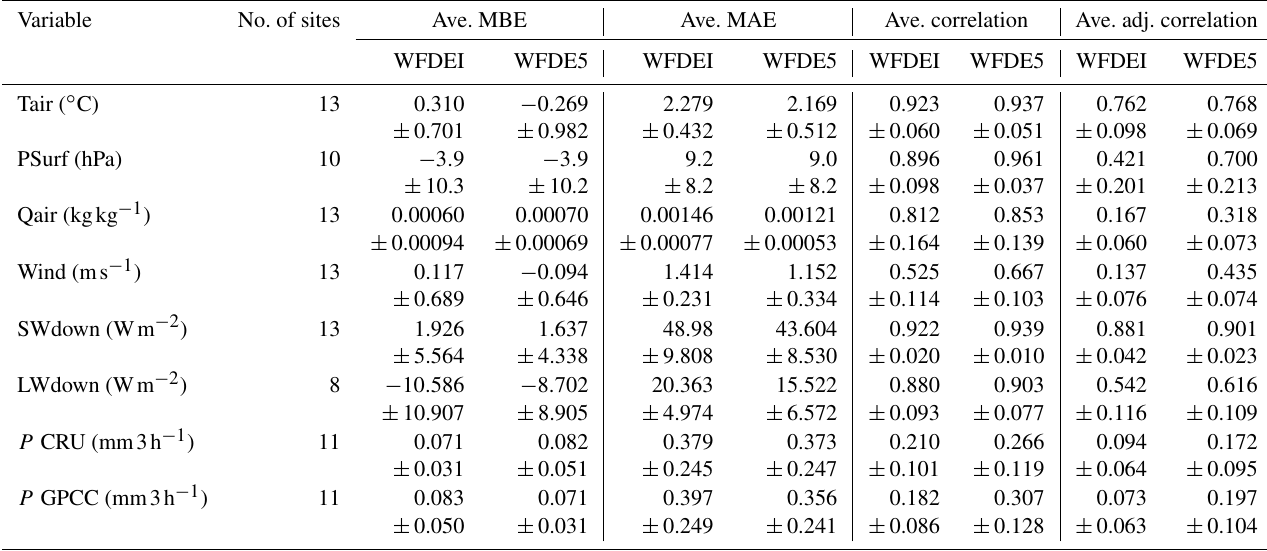
Table A18. Average metrics across all 13 FLUXNET2015 sites ± 95% confidence intervals of the means for WFDEI versus FN2015